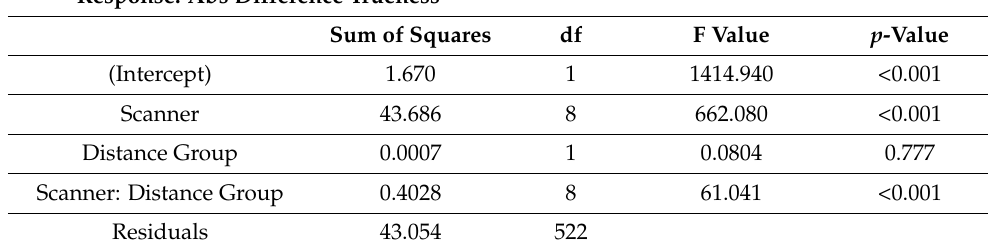
Table 2. ANOVA results for trueness.